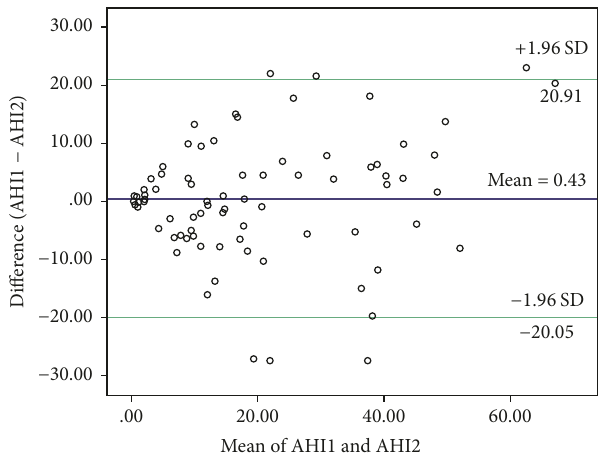
Figure 1: Bland-Altman plot shows the agreement between the apnea-hypopnea-index obtained from the first and second night of the ambulatory sleep testing. AHI: apnea-hypopnea-index; SD: standard